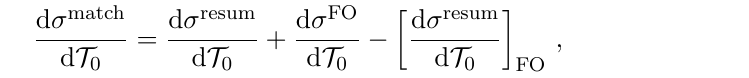
Compared to the full NNLL 0 result, the approximate NNLL 0 only finite O ( α 2 ) terms proportional to δ ( T 0 ) in the hard and soft s